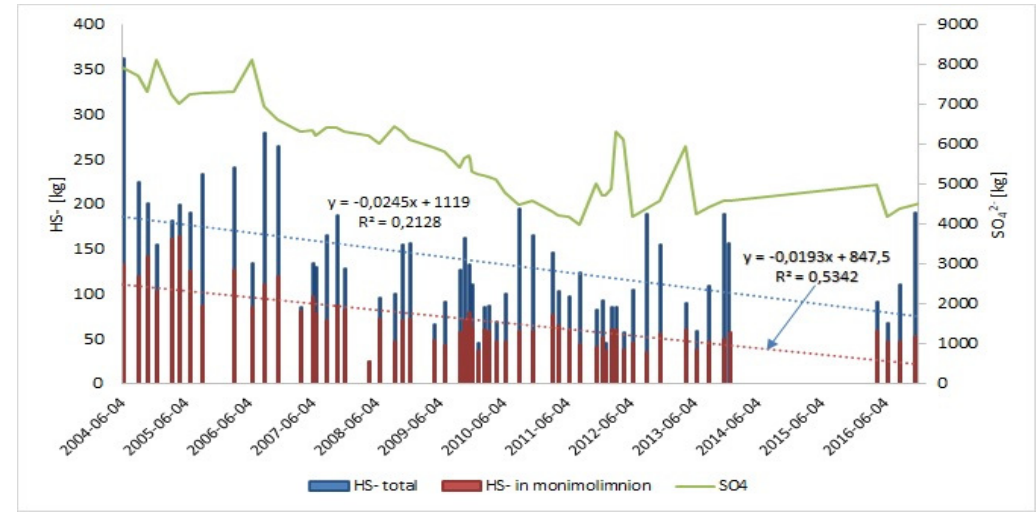
Figure 5. Total amount of sulphate and hydrogen sulphide in Lake Starodworskie water.